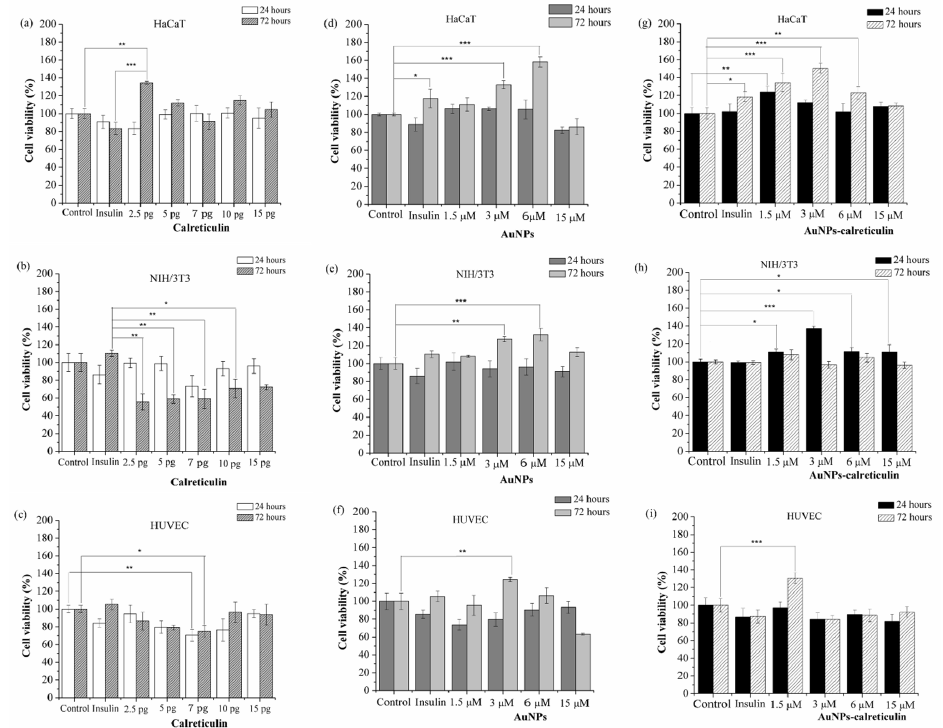
Figure 5. Cell viability assay. Cells treated with calreticulin ( a – c ), cells treated with AuNPs ( d – f ), and cells treated with AuNPs calreticulin ( g – i ). The viability of NIH/3T3 decreased significantly with calreticulin. Significant difference at * p < 0.05, ** p < 0.01 and *** p < 0.0001.